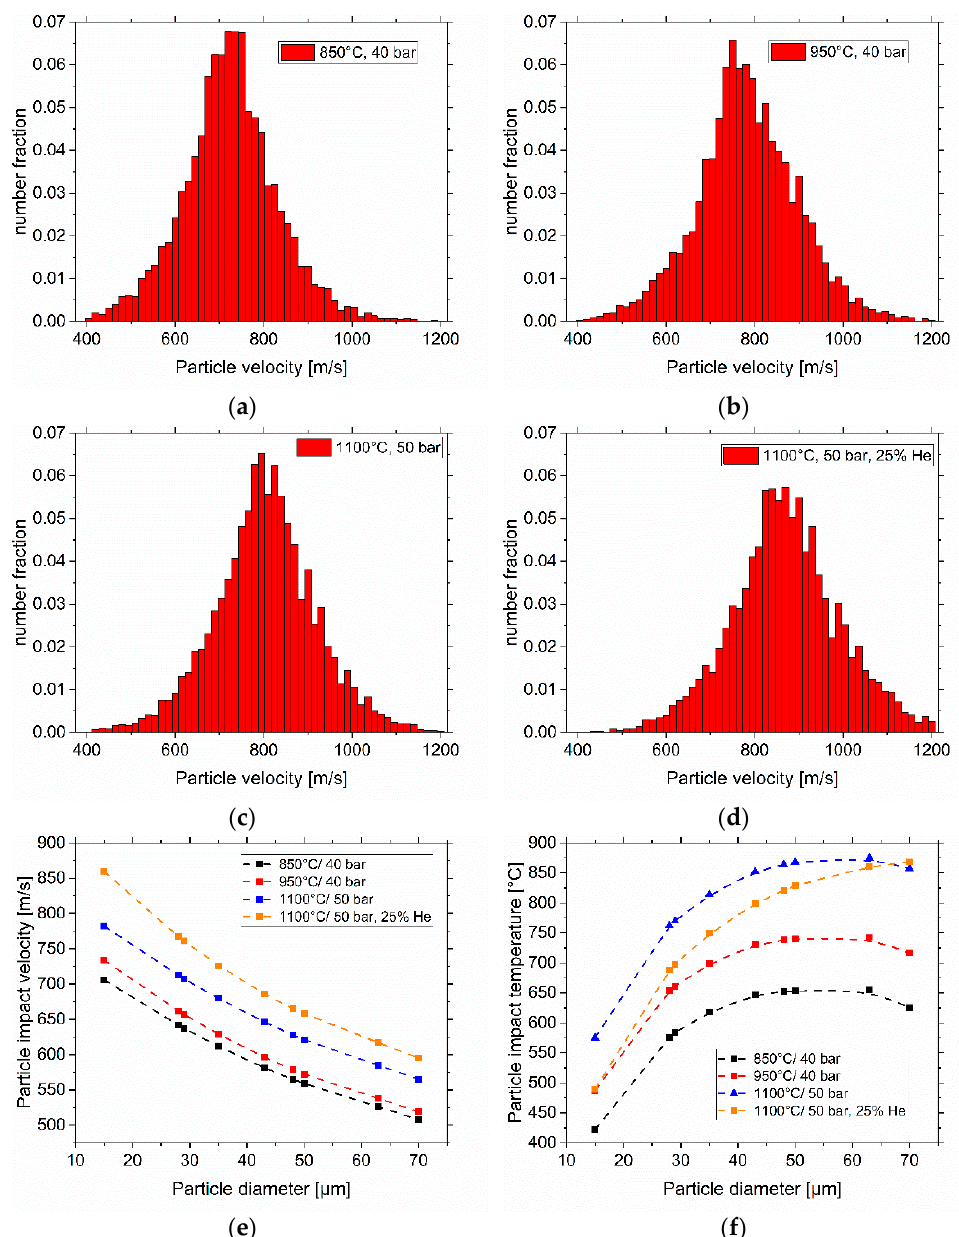
Figure 2. Particle velocity distributions measured with a cold spray meter: ( a ) 850 °C, ( b ) 950 °C, ( c ) 1100 °C and ( d ) 1100 °C and 25% He. The detailed spray parameters can be found in Table 1. The particle impact velocities and particle impact temperatures depending on particle diameter and spray parameters are presented in ( e , f ), respectively. For the calculations, KSS software was used. For certain particle diameters, the values can be found in Table 3.